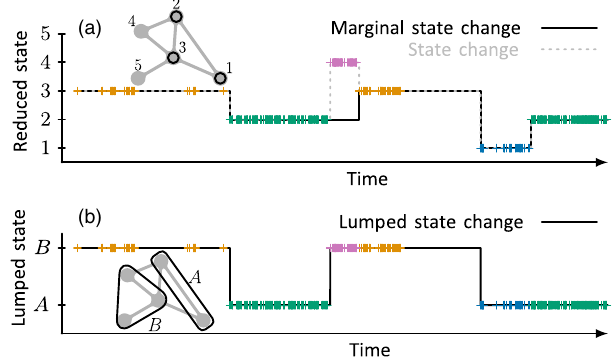
FIG. 8. Marginal observations and lumping of states. (a) Mar- ginal state-change trajectory (black line) if states 4 and 5 are hidden. (b) Lumping of states into A ¼ f 1 ; 2 g and B ¼ f 3 ; 4 ; 5 g . The colored crosses correspond to state visits of all five states as in Fig.